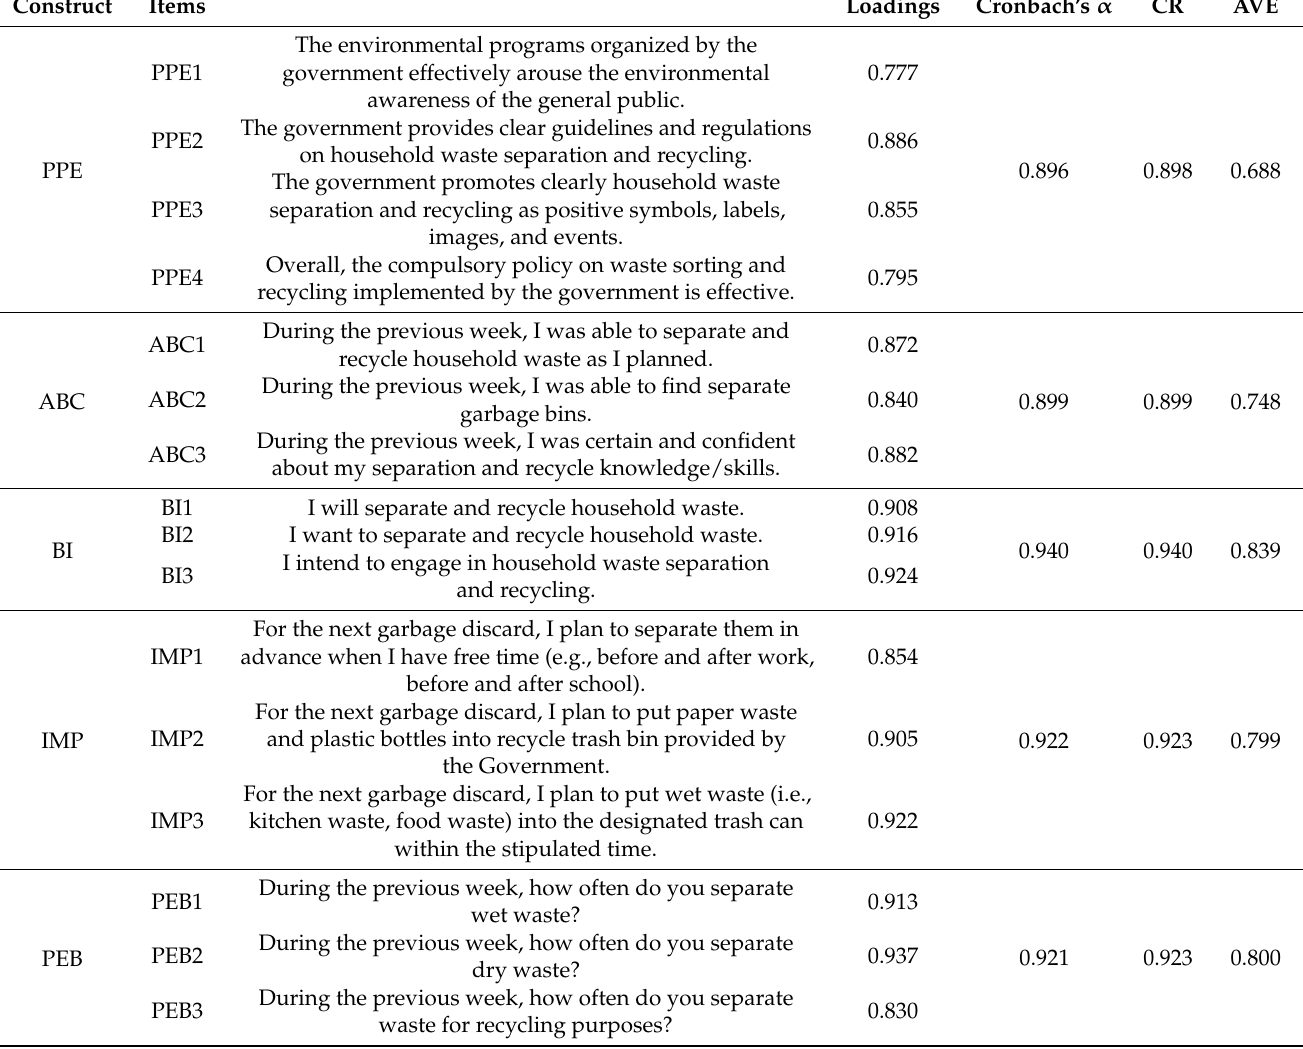
Table 4. Results of confirmatory factor